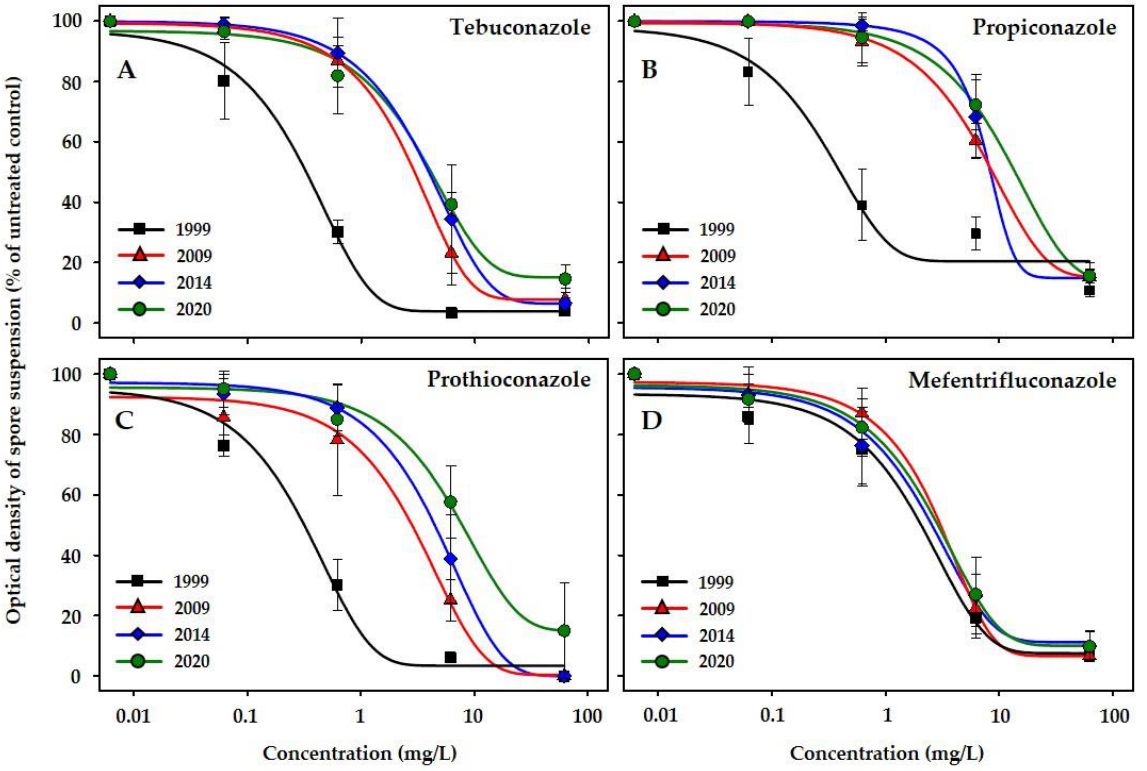
Figure 1. Relationship between fungicide concentration (mg/L) of tebuconazole ( A ), propiconazole ( B ), prothioconazole ( C ), mefentrifluconazole ( D ), and optical density of spore suspension of Zymoseptoria tritici field populations isolated from wheat crops (cultivar “Ritmo”) at two locations in northern Germany between 1999 and 2020 (isolation years 1999, 2009, 2014, and 2020) using microtiter assays. Optical density data (mean ± SD) of the several fungicide concentrations are expressed relative to the optical density of the fungicide untreated control. Means ( ± SD) were calculated for each year of Z. tritici isolation and each concentration including both locations and three replications per location.